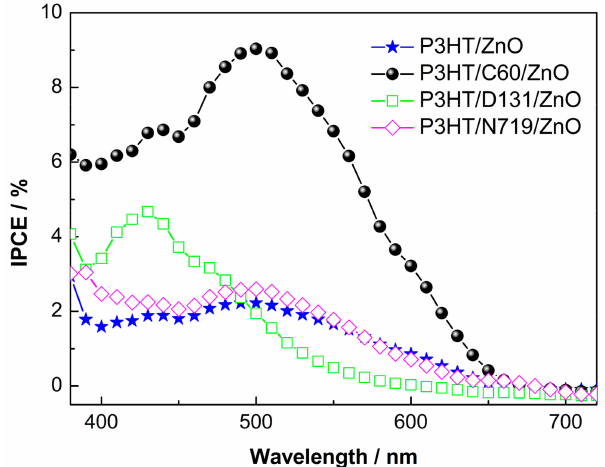
Figure 7. IPCE spectra of the hybrid solar